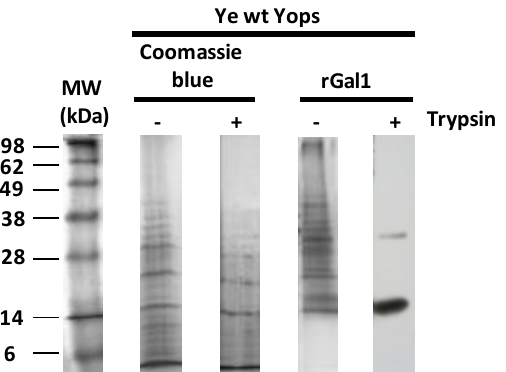
Figure 4. Gal1 protects virulence factors secreted by Ye from protease degradation. Electrophoresis was performed in an SDS-polyacrylamide gel (25 µ L per well of Ye wt Yops; 20–40 µ g/well). Subse- quently, gels were treated with trypsin (200 µ g/mL). Detection was performed by Coomassie blue staining or revealed by chemiluminescence. Data are representative of two independent